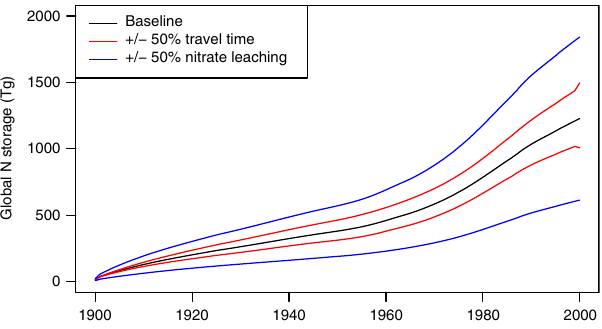
Fig. 1 Modelled global increase in nitrate stored in the vadose zone between 1900 and 2000. Nitrate storage (in Tg N) is modelled under the baseline model run (black) and from sensitivity analyses (red and blue for +/ − 50% travel time and nitrate leaching,